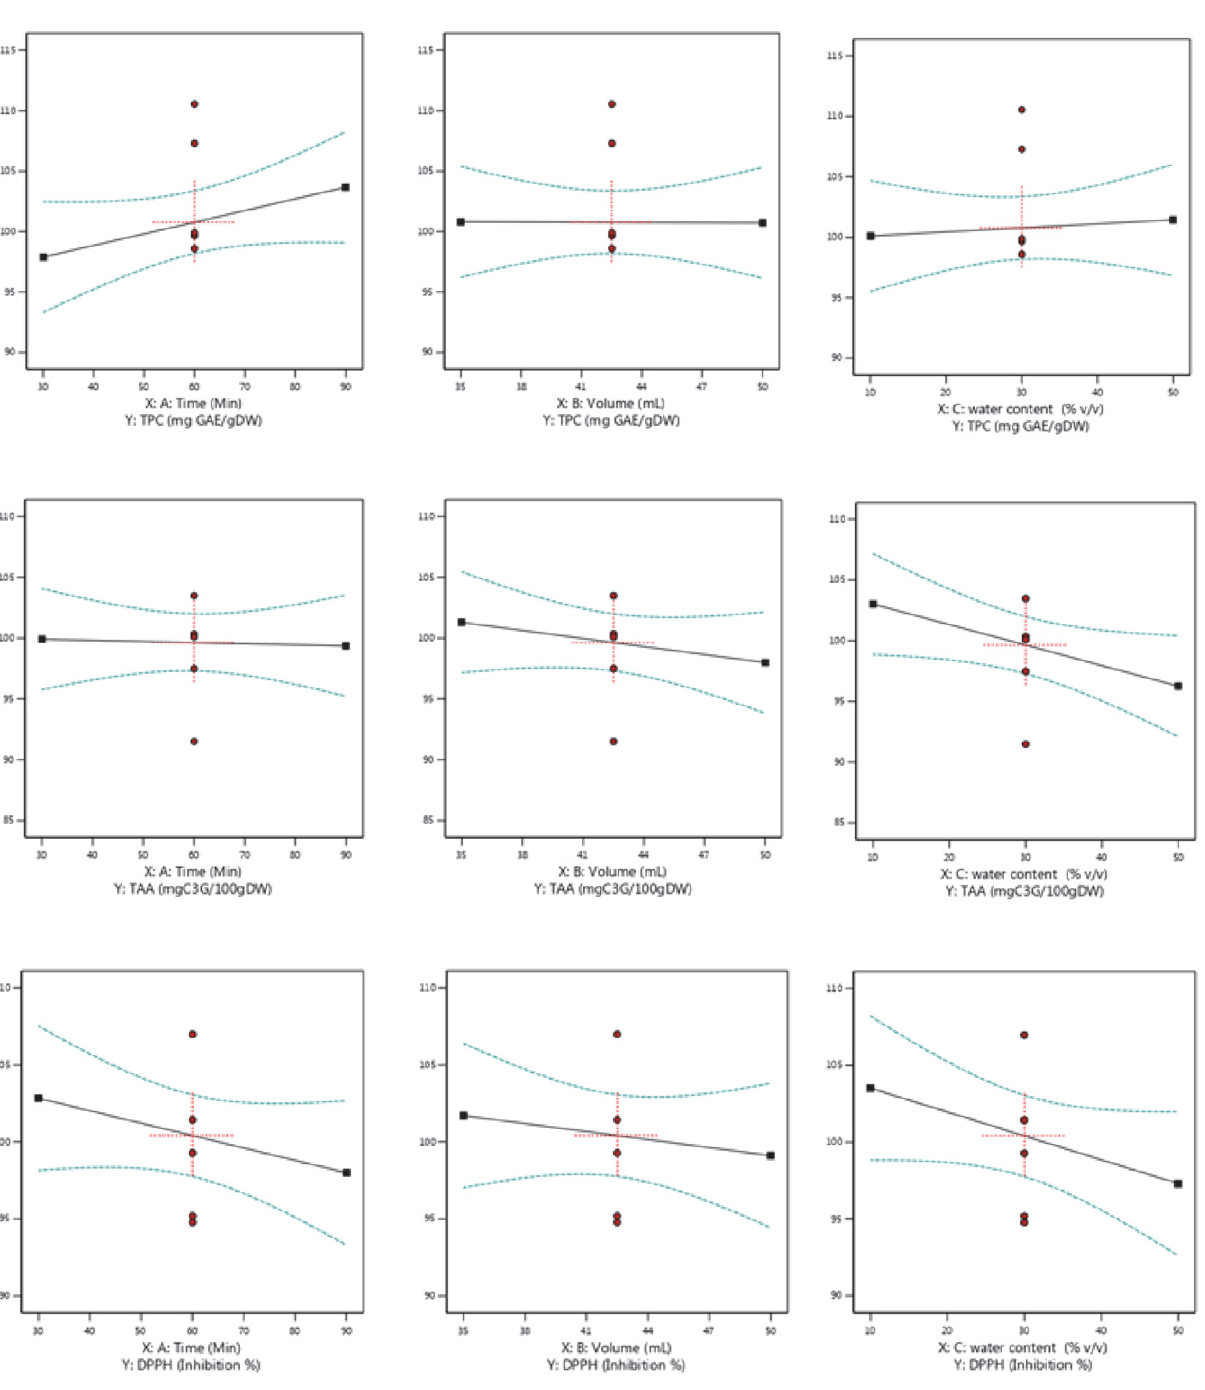
Figure 4. The effect of DES extraction parameters (time, solvent volume, water content) on TPC, TAA, and DPPH